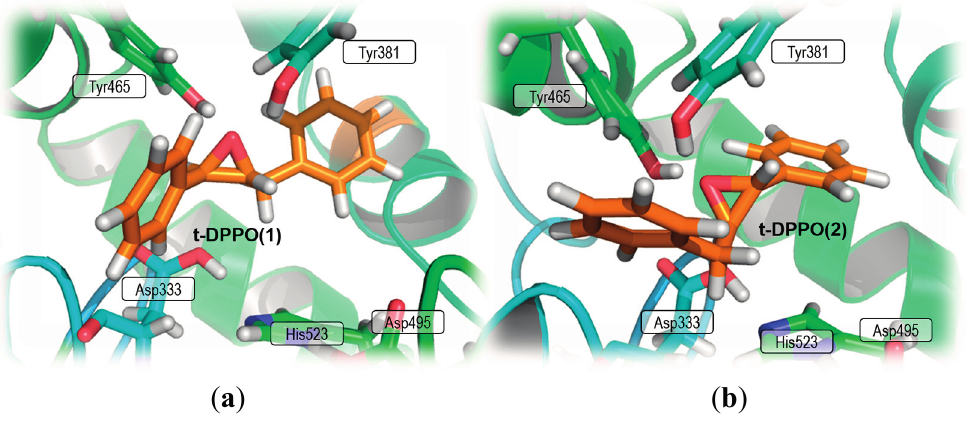
Figure 1. Active site of sEH with bound substrate ( a ) t-DPPO(1) and ( b ) t-DPPO(2)